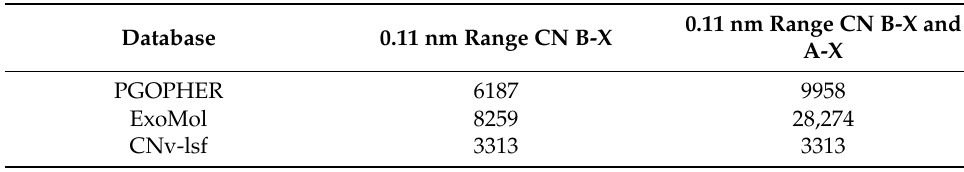
Table 10. Number of transitions of the simulated spectra in the measured experimental ranges for